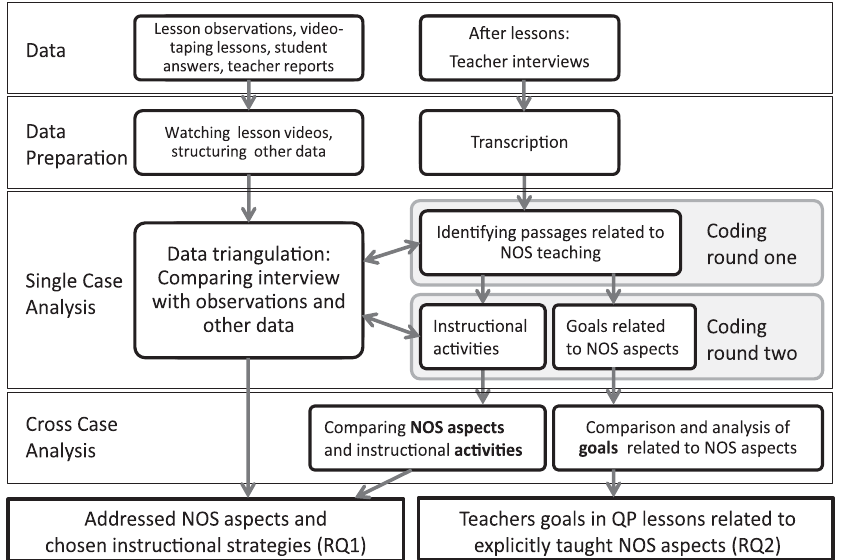
TABLE III. Teacher characteristics and data availability.